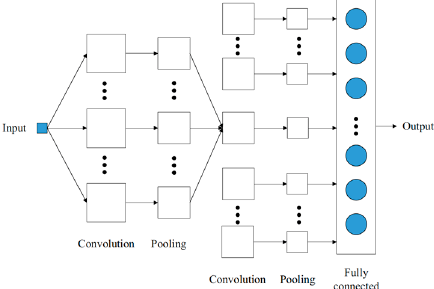
Figure 1. The Convolutional Neural Network Structure.